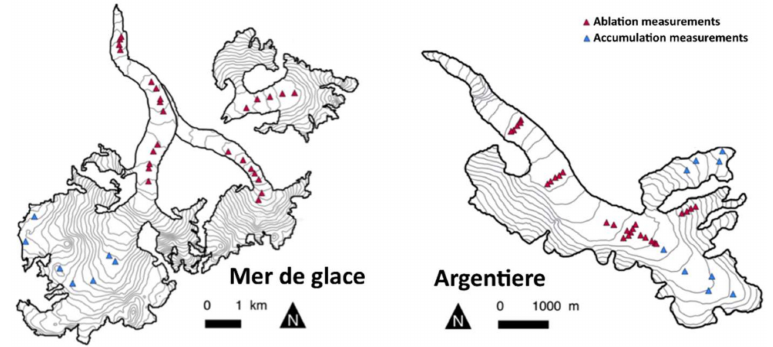
Figure 2. Glacier surface mass balance (SMB) measurement locations for ablation and accumulation areas in the Mer de Glace and Argenti è re